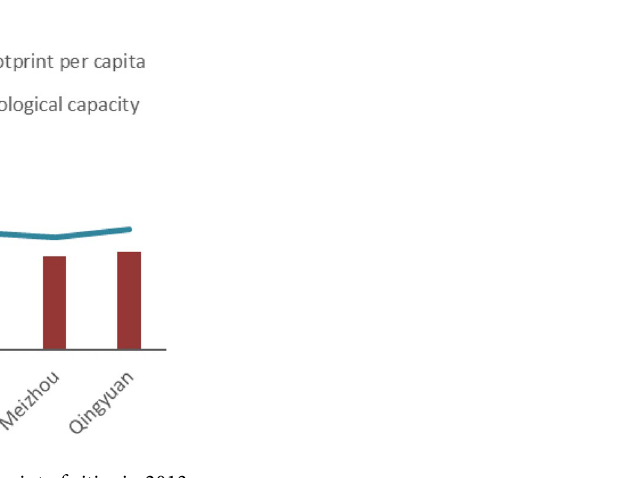
Figure 7. Analysis of ecological footprint of cities in